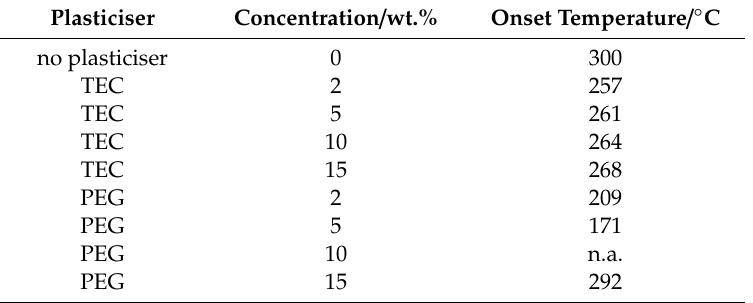
Table 2. Decomposition temperatures of pure and plasticised poly(3-hydroxybutyrate-co-3-hydroxyvalerate) (PHBV) measured with thermogravimetric analysis (TGA). TEC: triethyl citrate, PEG: polyethylene